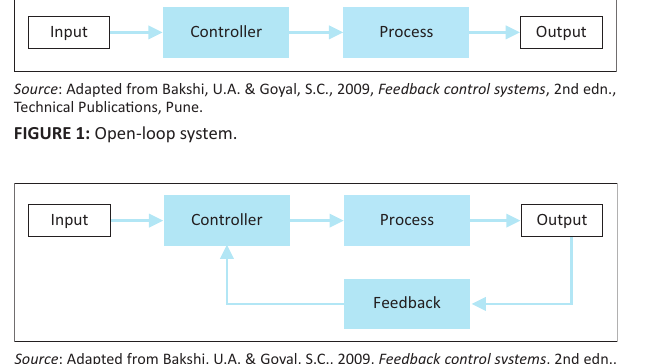
FIGURE 2: Closed-loop